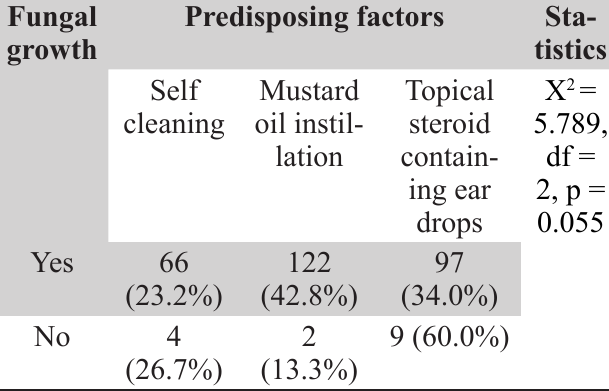
Table 3. Association of fungal growth